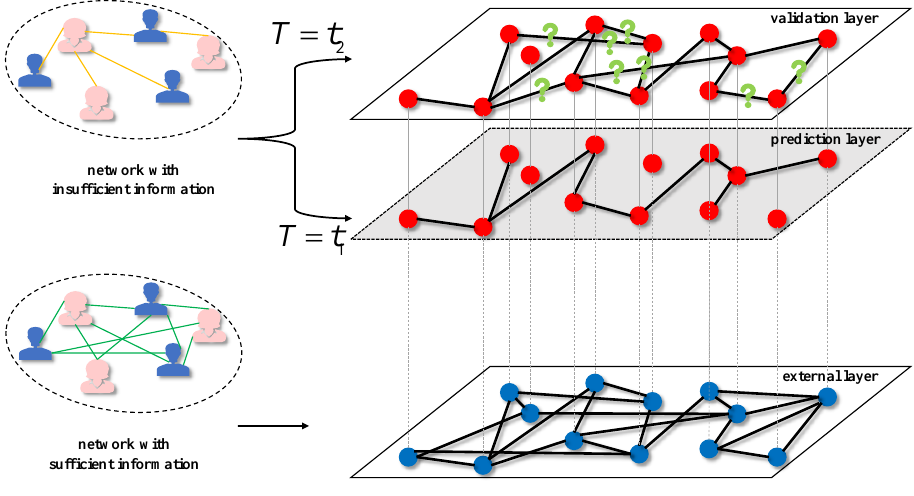
Figure 2. Multiplex network structure of two social platforms. The multiplex network has three layers, including an external layer, prediction layer and validation layer. The external layer is modelled from the platform with sufficient information, and the validation layer is modelled from the platform with insufficient information. The prediction layer is generated by randomly removing several edges from the validation layer. In our model, we use the external layer and the prediction layer to predict links in the validation